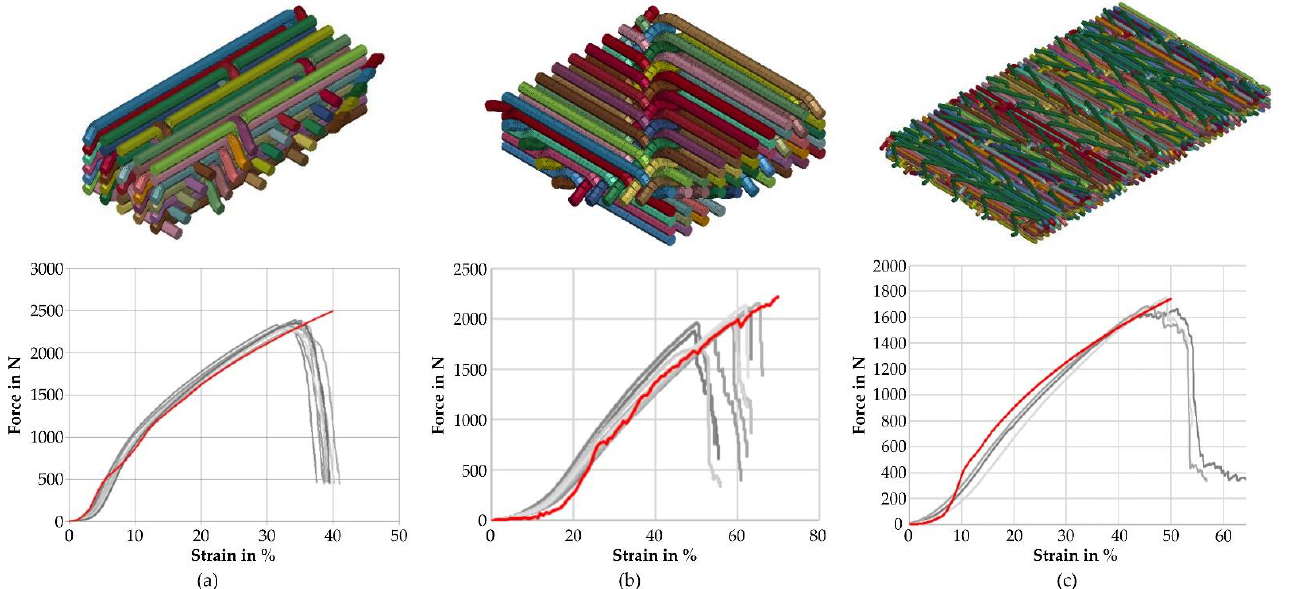
Figure 9. FEM models and force-strain-curves of selected weaving geometries (grey — experiments, red — simulation), ( a ) Layer-to-layer satin, ( b ) Angle-through-thickness, ( c ) ORW1.